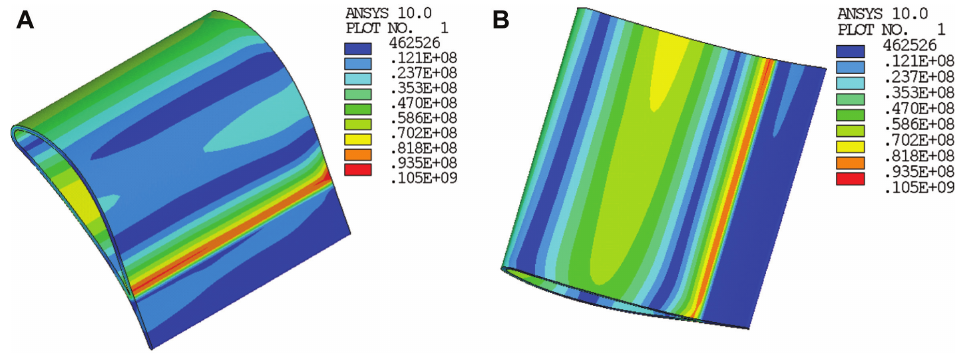
Figure 4 Stress